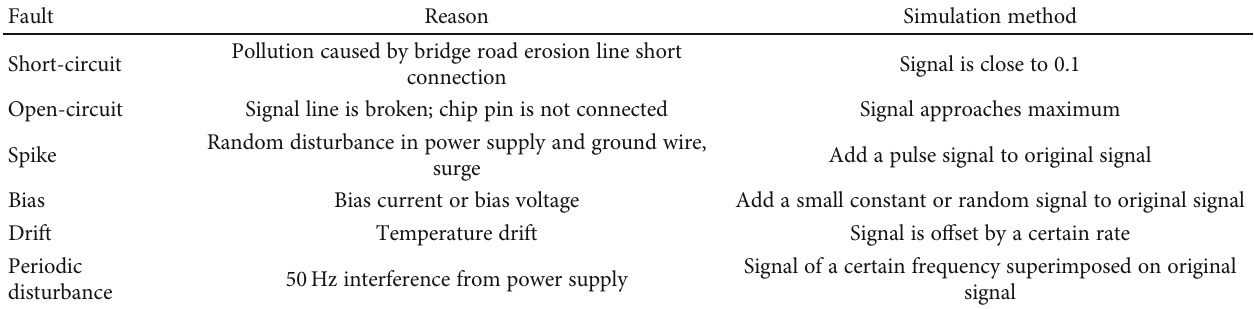
Figure 10: A fl owchart of Table 2: Common sensor types, fault causes, and simulation methods.